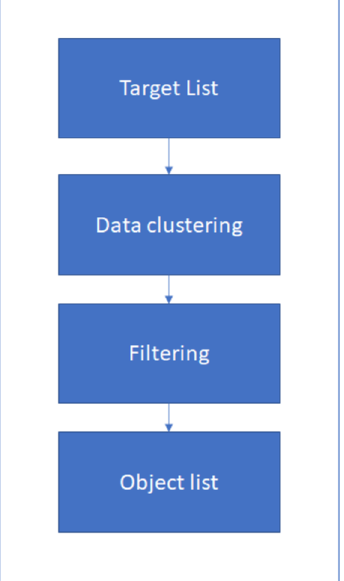
Figure 4. Post-processing-based RaDAR object detection.